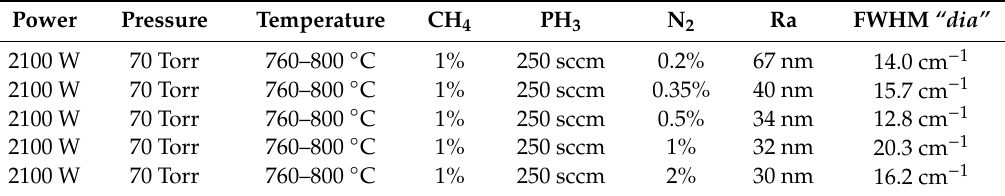
Table 1. Growth conditions used during the microwave plasma-enhanced chemical vapor deposition (MWPECVD) deposition of the nanocrystalline diamond (NCD) layers, Ra determined by AFM and full width at half maximum (FWHM) of the dia peak, corresponding to the Raman